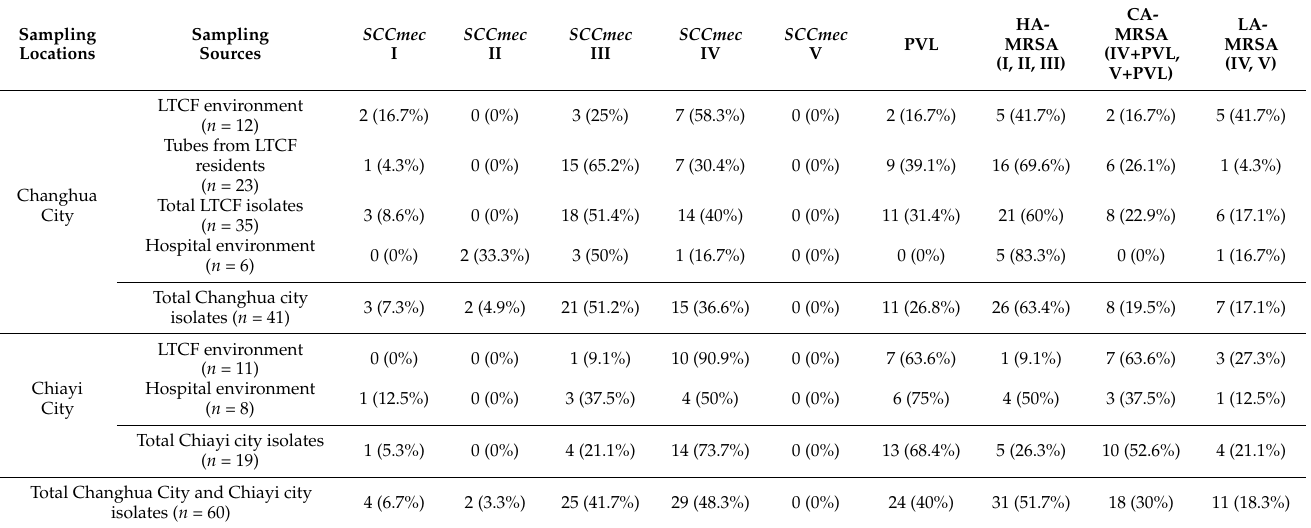
Table 2. SCCmec PCR typing results of the 60 MRSA